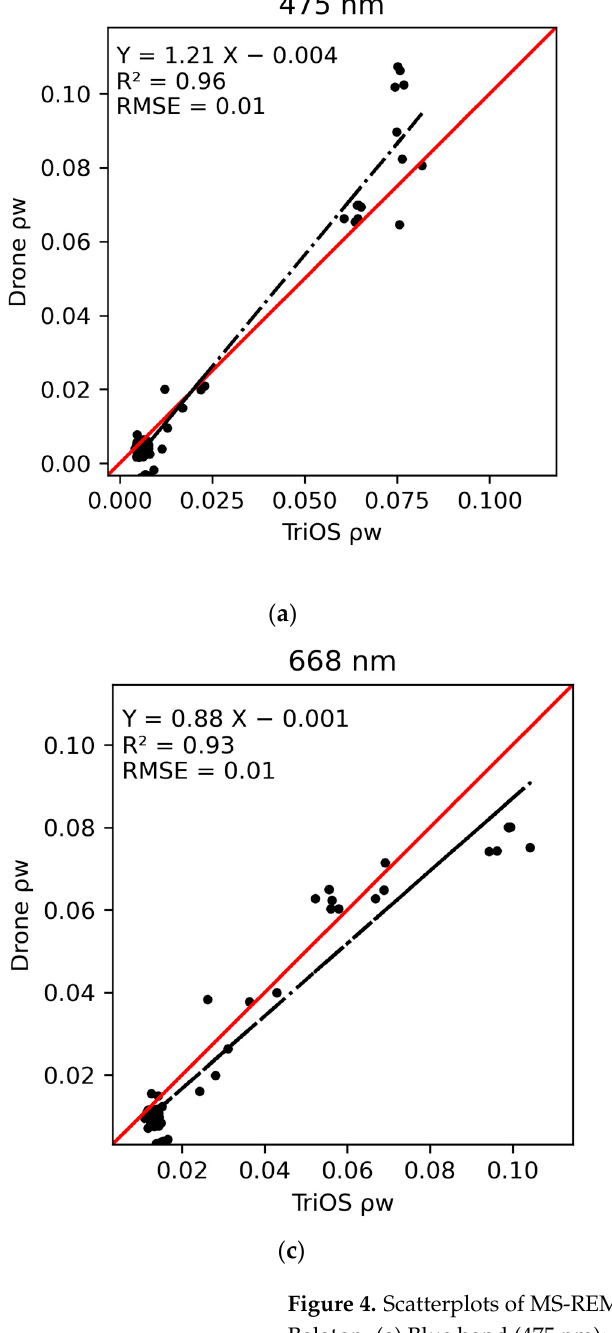
Figure 3. Mean Water-Leaving Reflectance of Drone (grey) and TriOS Ramses (black) data plotted for two different flights at Lake Balaton (Lake Balaton and Kiss Balaton). The upper plots ( a , b ) show the reflectance without RedEdge-NIR subtraction. The lower plots ( c , d ) show the reflectance with RedEdge-NIR subtraction.